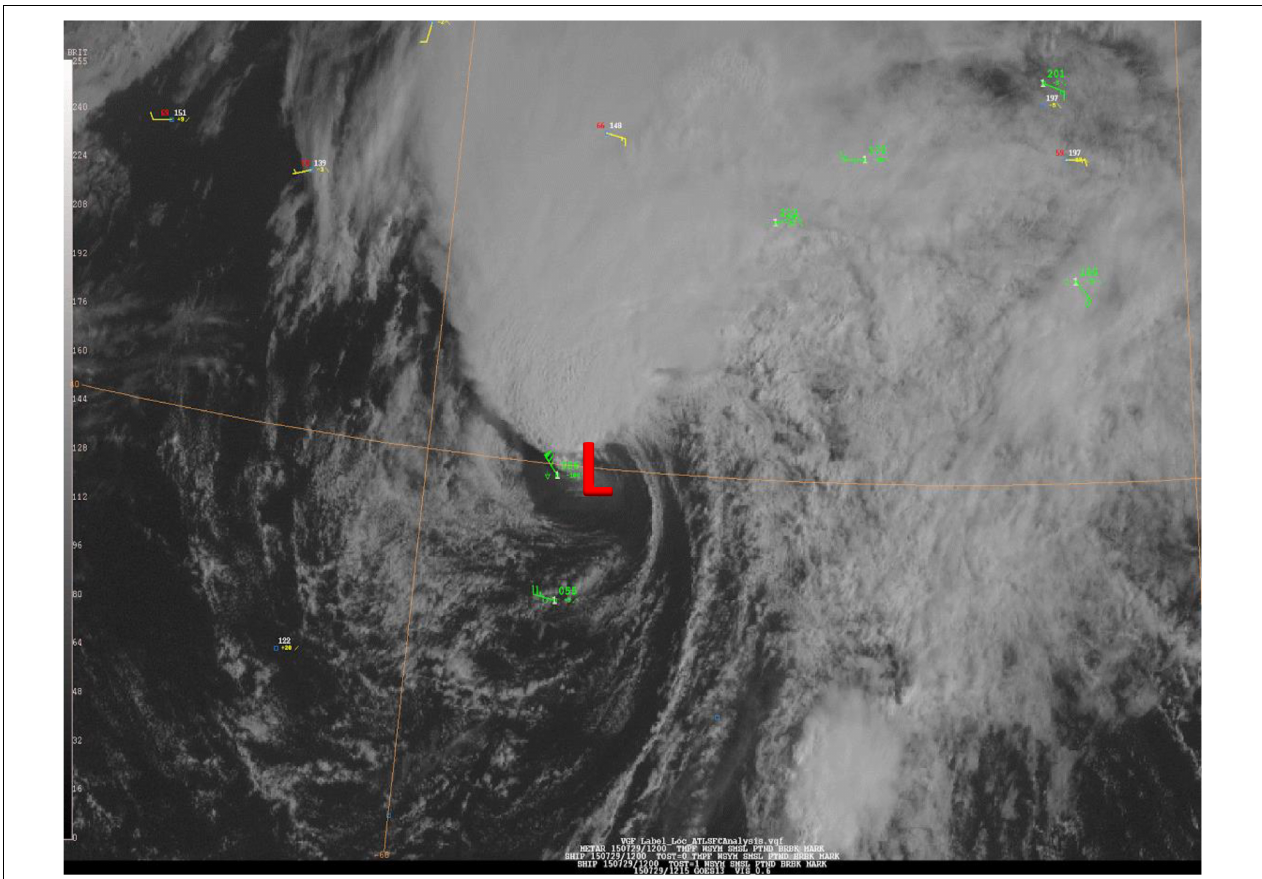
FIGURE 2 | Visible satellite image with available ship observations (overlain in green and yellow using standard synoptic station notation) in the central Atlantic Ocean (1200 UTC, 29 July 2015). Based on this image, the low pressure is centered near 40 ◦ N, 58 ◦ W. Courtesy of National Oceanic and Atmospheric Administration, National Weather Service, Ocean Prediction Center.